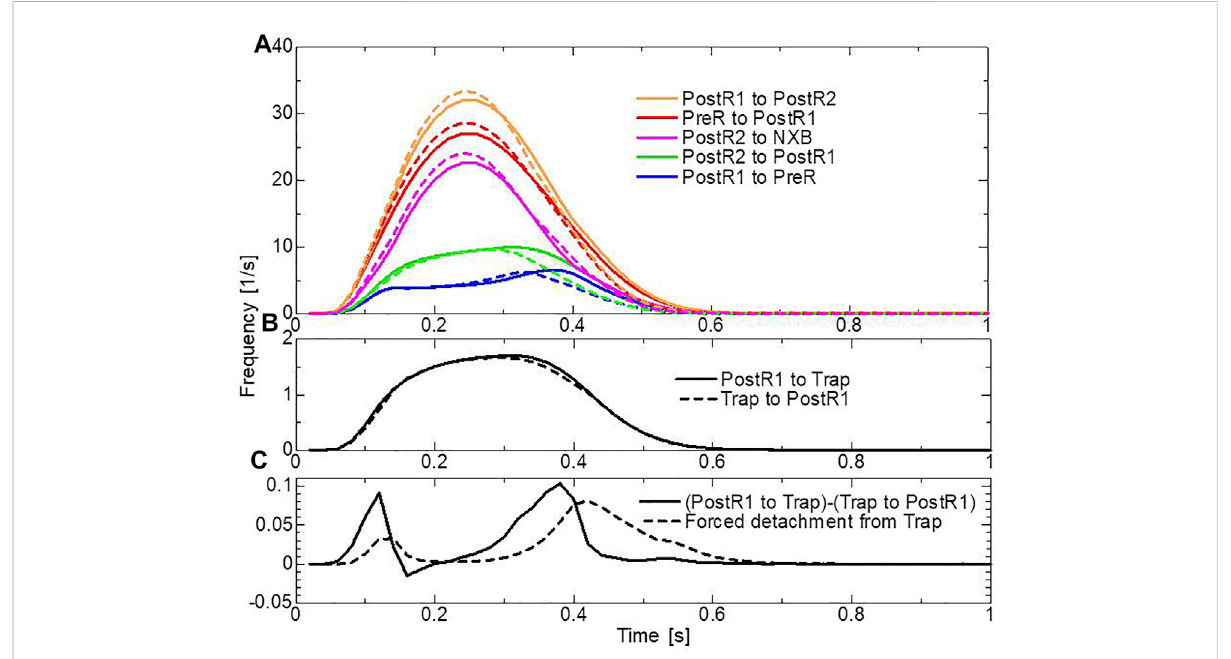
FIGURE 14 Transition frequencies ofbindingMHsduringaheartbeat. (A) ThefrequenciesperMHofthetransitionsfrom XB PostR1 to XB PostR2 (orange), XB Pre to XB PostR1 (red), XB PostR2 to N XB (pink), XB PostR2 to XB PostR1 (green), and XB PostR1 to XB PreR (blue). The solid and broken lines represent the trap model and the no-trap model, respectively. (B) Frequencies per MH of trapping (solid line) and escaping (broken line). (C) The difference between the trapping frequency and the escaping frequency (solid line), and the frequency of the forced detachment from XB Trap